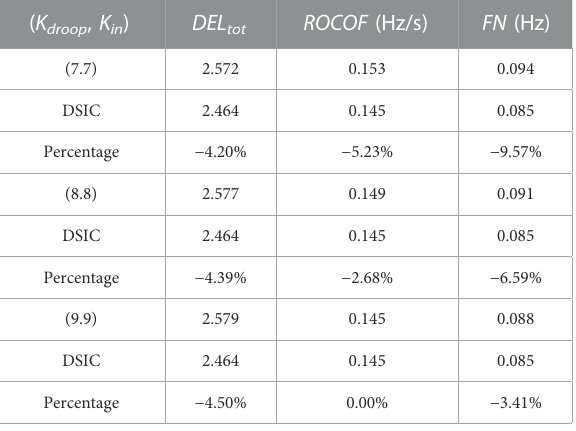
TABLE 6 DEL tot and ROCOF and FN under the fi xed gain and DSIC